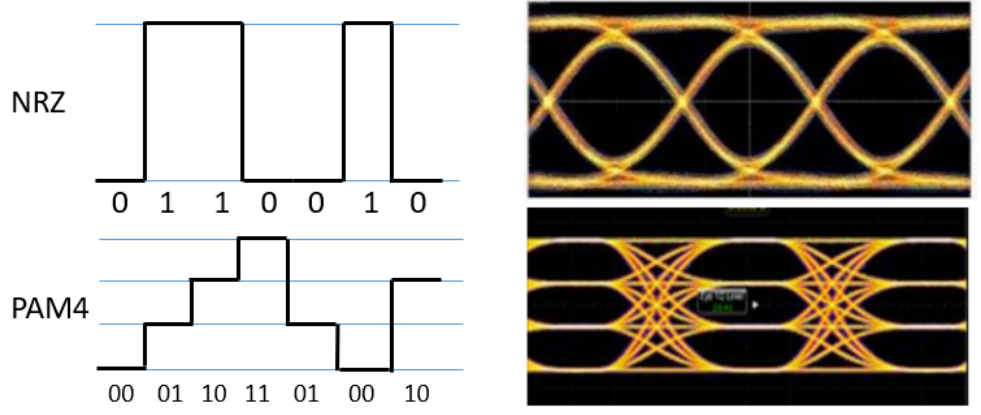
Figure 1. Comparison of non-return-to-zero (NRZ) and level-four pulse-amplitude modulation (PAM4) signals